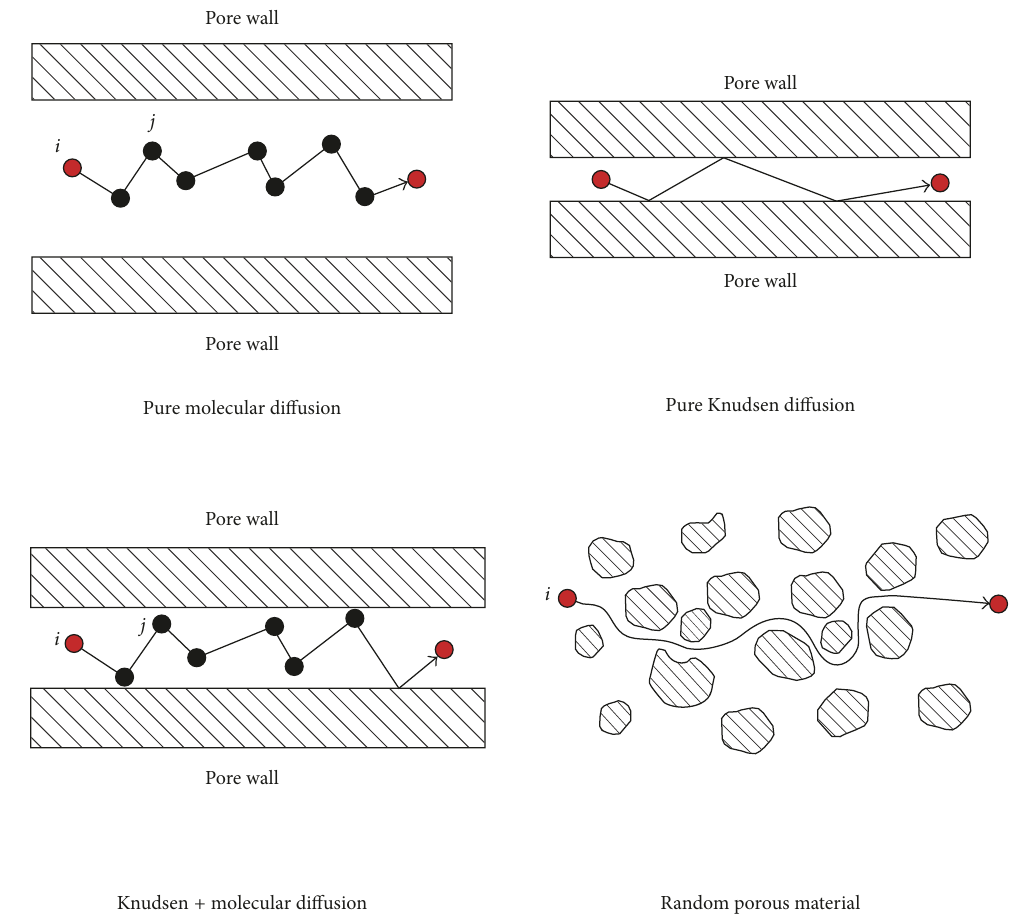
Figure 9: Types of porous diffusion. Shaded areas represent nonporous solids (adapted from